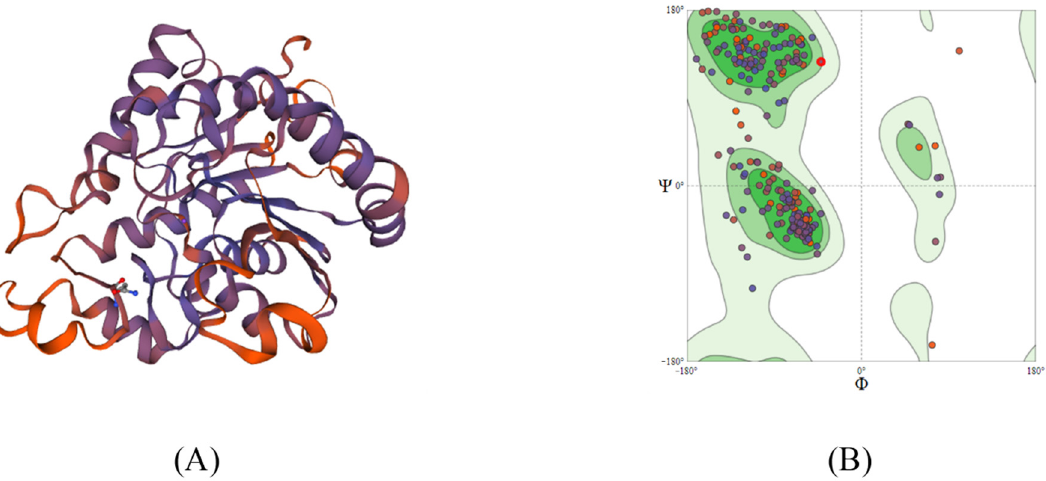
Figure 5. ( A ) Swiss-Model of HDAC11; ( B ) Ramachandran plot analysis of the structure of HDAC11 model (Figures were prepared using Chimera 1.14 and SWISS–MODEL